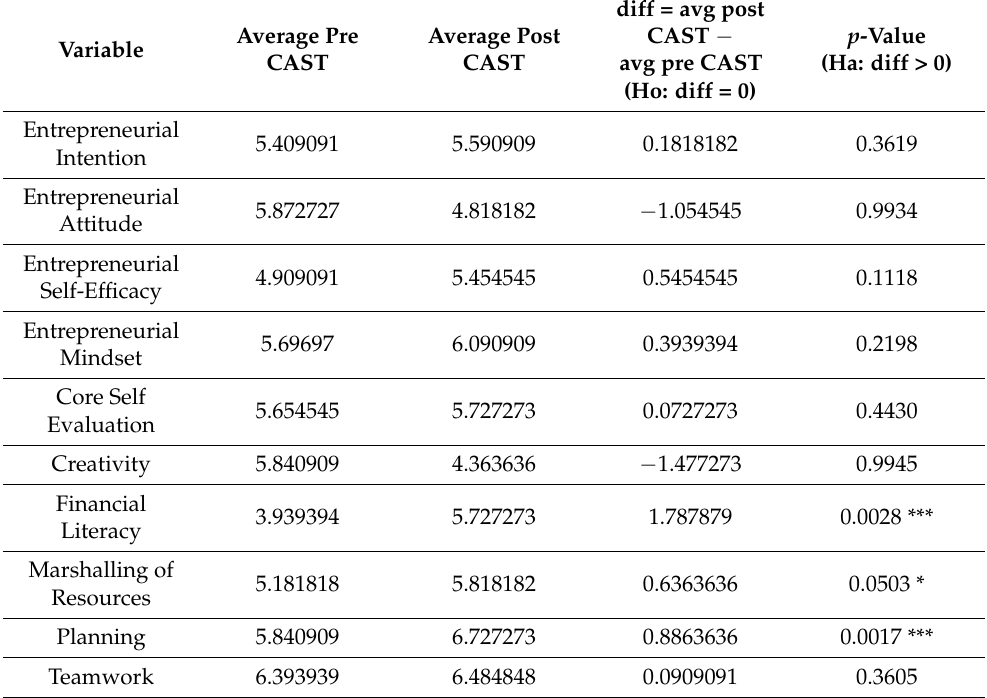
Table A9. Output of t -tests on entrepreneurial characteristics, pre- and post-course, of the students who worked on entrepreneurial ideas proposed by other